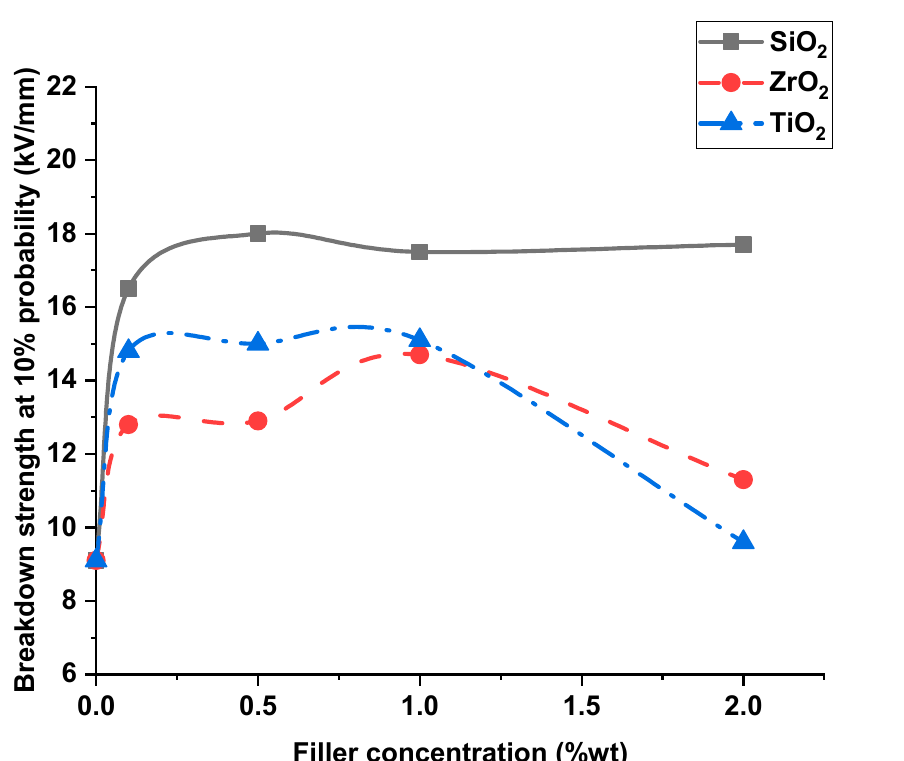
Figure 11. Breakdown strength at 10% probability of silicone rubber containing different types of nanoparticles (SiO 2 , ZrO 2 and TiO 2 ).